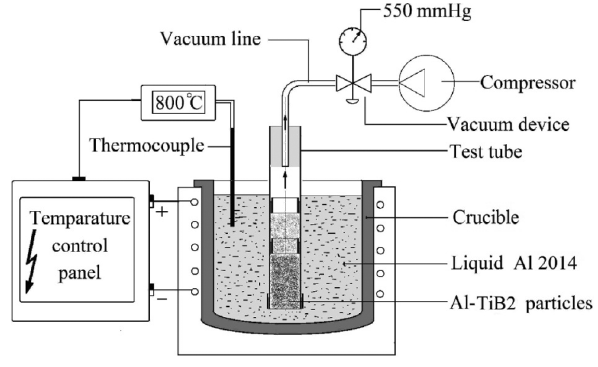
Fig. 1: A prototype vacuum infiltration test apparatus used to produce the composites